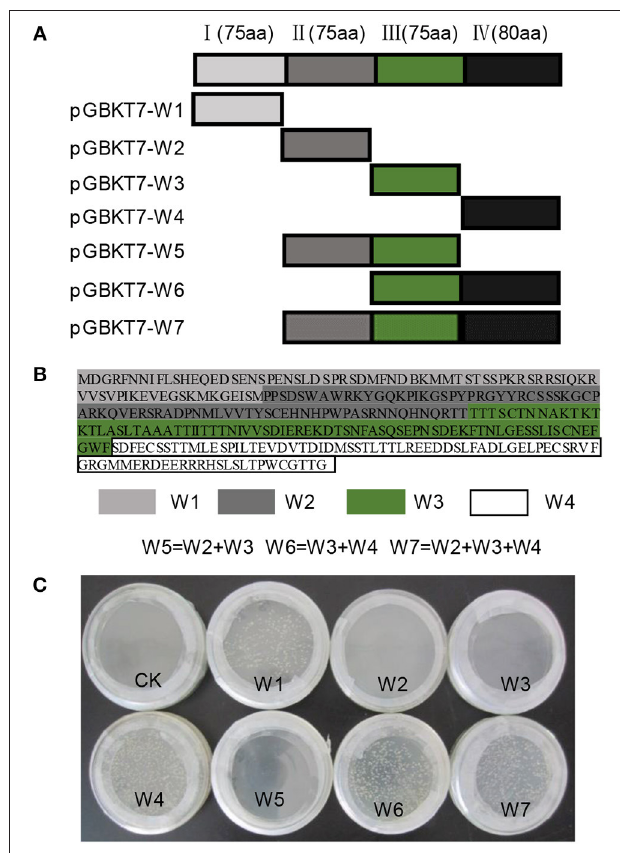
FIGURE 7 | The transcriptional activation analysis of NtWRKY-R1. (A,B) the protein fragment of NtWRKY-R1. This protein contains the W1, W2, W3, and W4 elements. Schematic diagrams of NtWRKY-R1 protein and its deletions were shown. (C) Testing autoactivation of NtWRKY-R1 by yeast two hybrid systems. The bait NtWRKY-R1 and its different elements were transformed into YH109 yeast stain to confirm autoactivation in the absence of a prey protein.